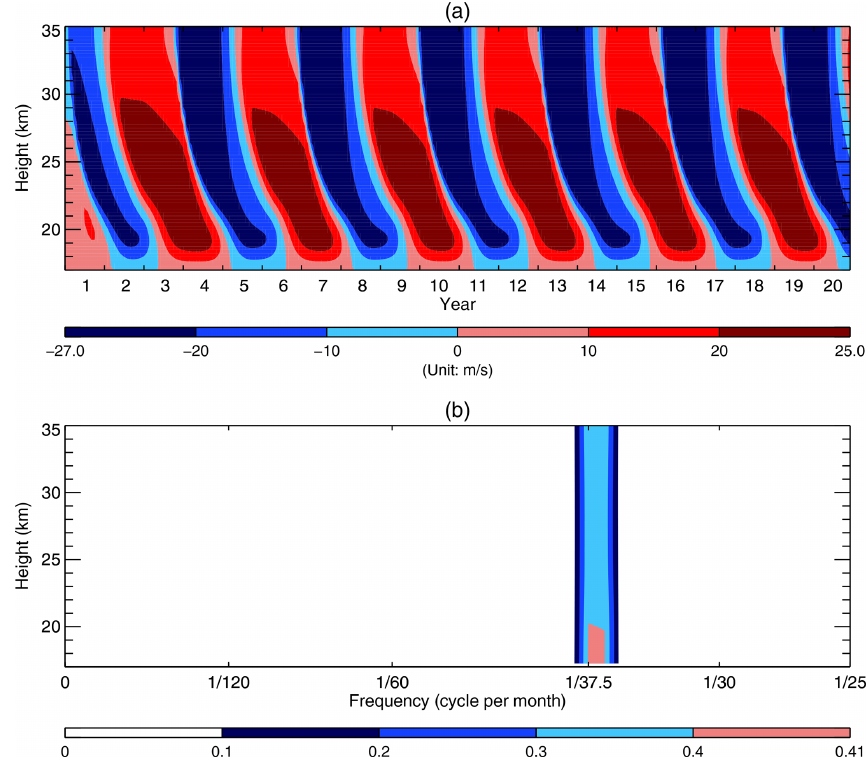
Figure 4. (a) Time–height section of the monthly averaged mean zonal wind over the first 20 years from the HL’s model without the semiannual forcing. (b) Frequency–height section of the power spectral densities (PSDs) of the standardized monthly averaged mean zonal wind of the 100 years. Note that in order to visualize the PSDs, we trimmed off the blank segment for the frequencies ranging from 1 0.5 cycles per